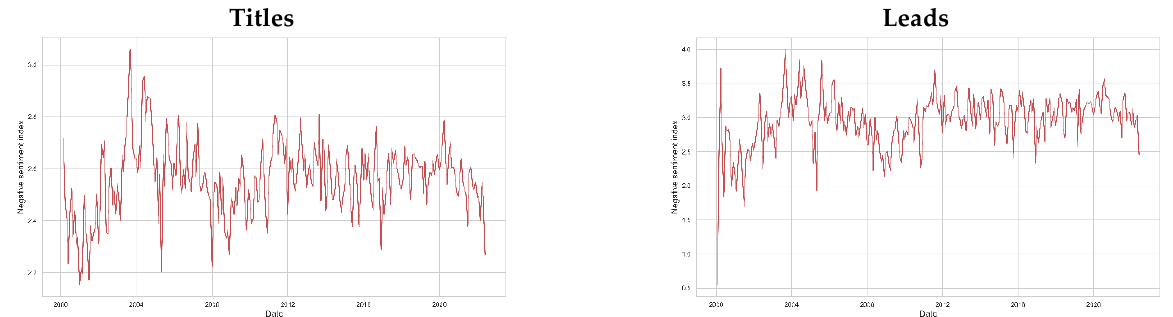
Figure A2. Sentiment analysis of news titles and leads over time for category “ Lithuania ” news.